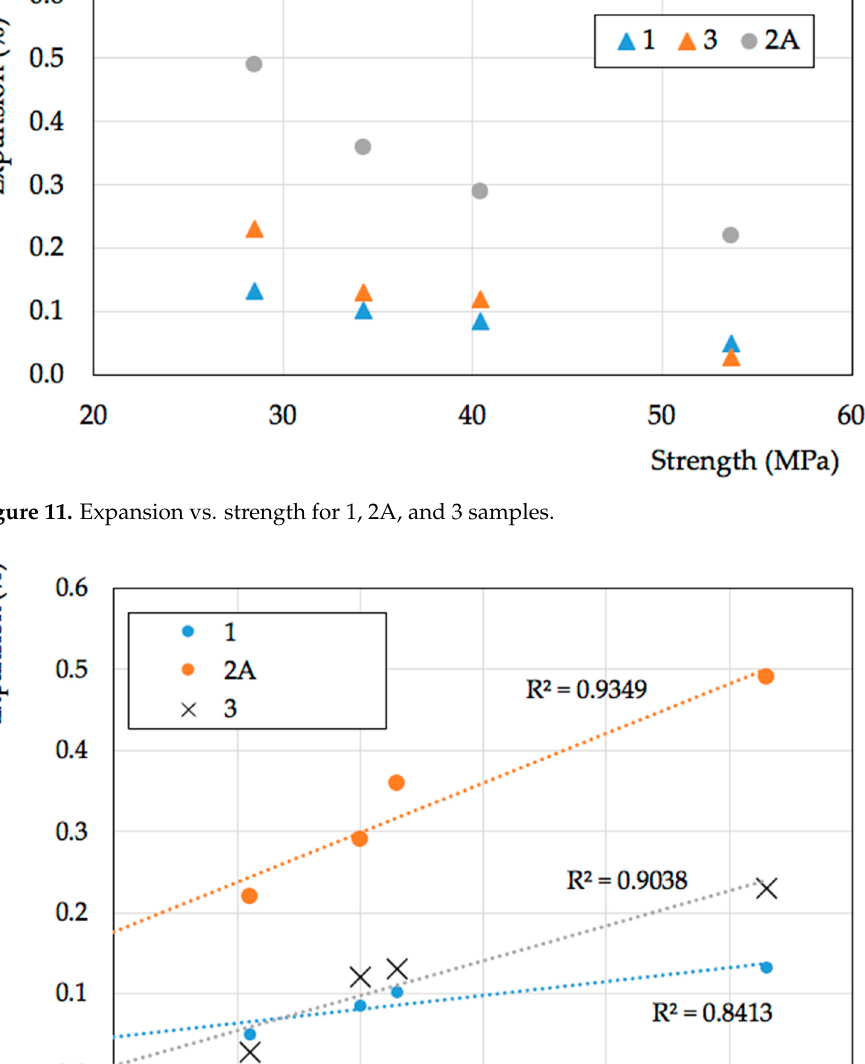
Figure 10. Expansion vs. mechanical strength for 2B mortars.